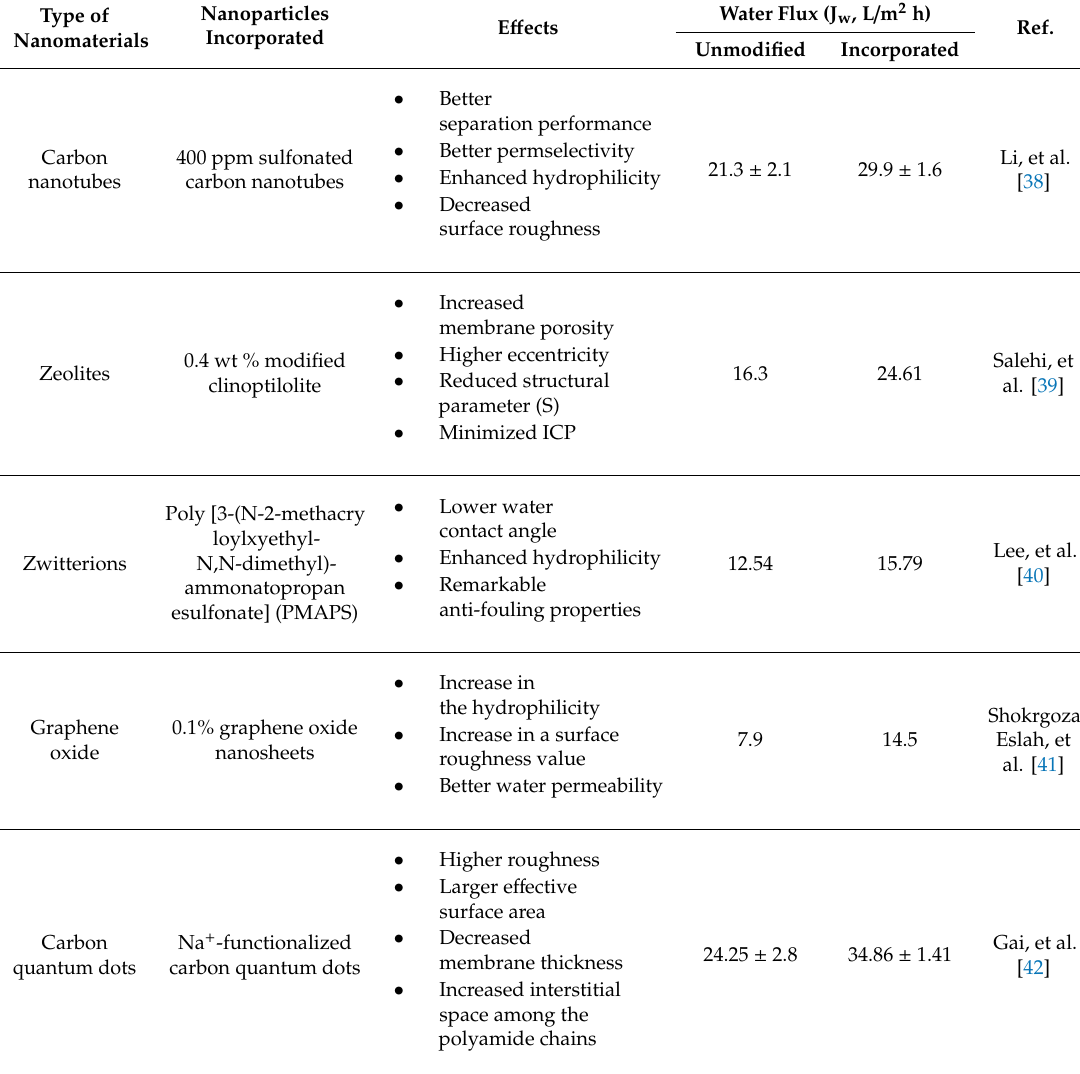
Table 2. Recent nanostructured osmotic membrane and their experimental performance. Type of